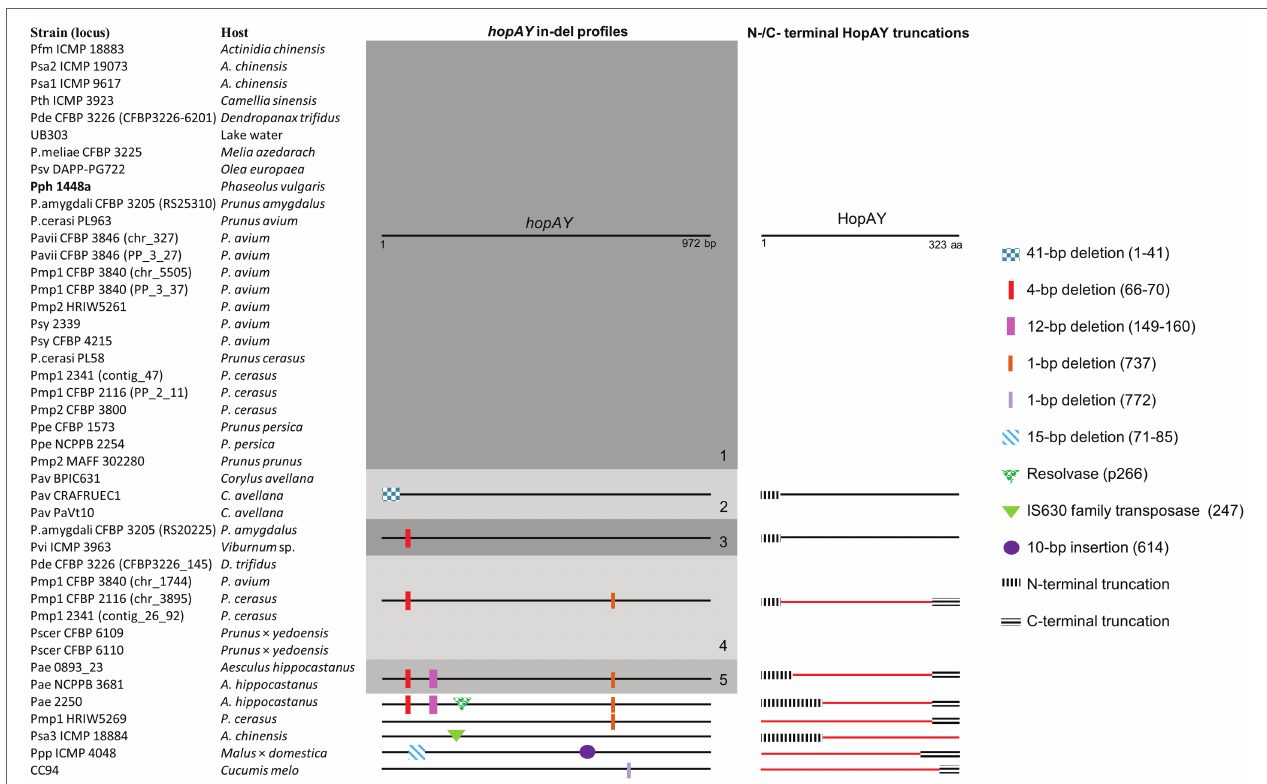
FIGURE 4 | Insertion–deletion profiles of hopAY retrieved by BLASTN and corresponding HopAY truncation scheme. Five major groups (1–5) were defined based on conserved indel mutations. Numbers in bracket indicate the position of the insertion or deletion based on the reference hopAY sequence from Pseudomonas syringae pv. phaseolicola 1448a (indicated in bold) available in the Hop database (PPI). HopAY proteins with a truncation affecting the catalytic domains characteristic for C58 cysteine protease and thus considered as non-functional are represented in red. The strain names used refer to the code field from Table 1 . Figure is not to